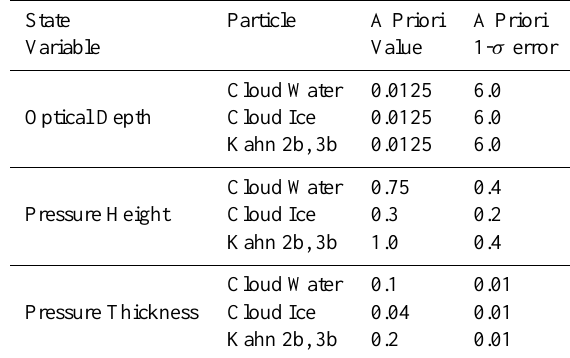
Table 1. A priori values and SDs for aerosol and cloud profiles. Note that the state vector contains the logarithm of the optical depth, so the σ range is a multiplicative scaling. The pressure heights and thicknesses are expressed as unitless ratios with the surface pres-